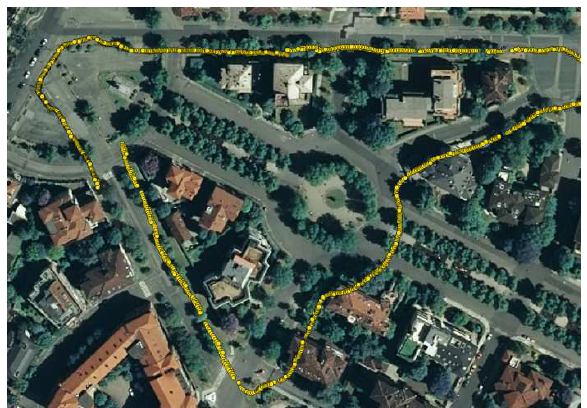
Figure 12. The aligned images (in blue) and the dense point cloud generated by the software Agisoft Photoscan.